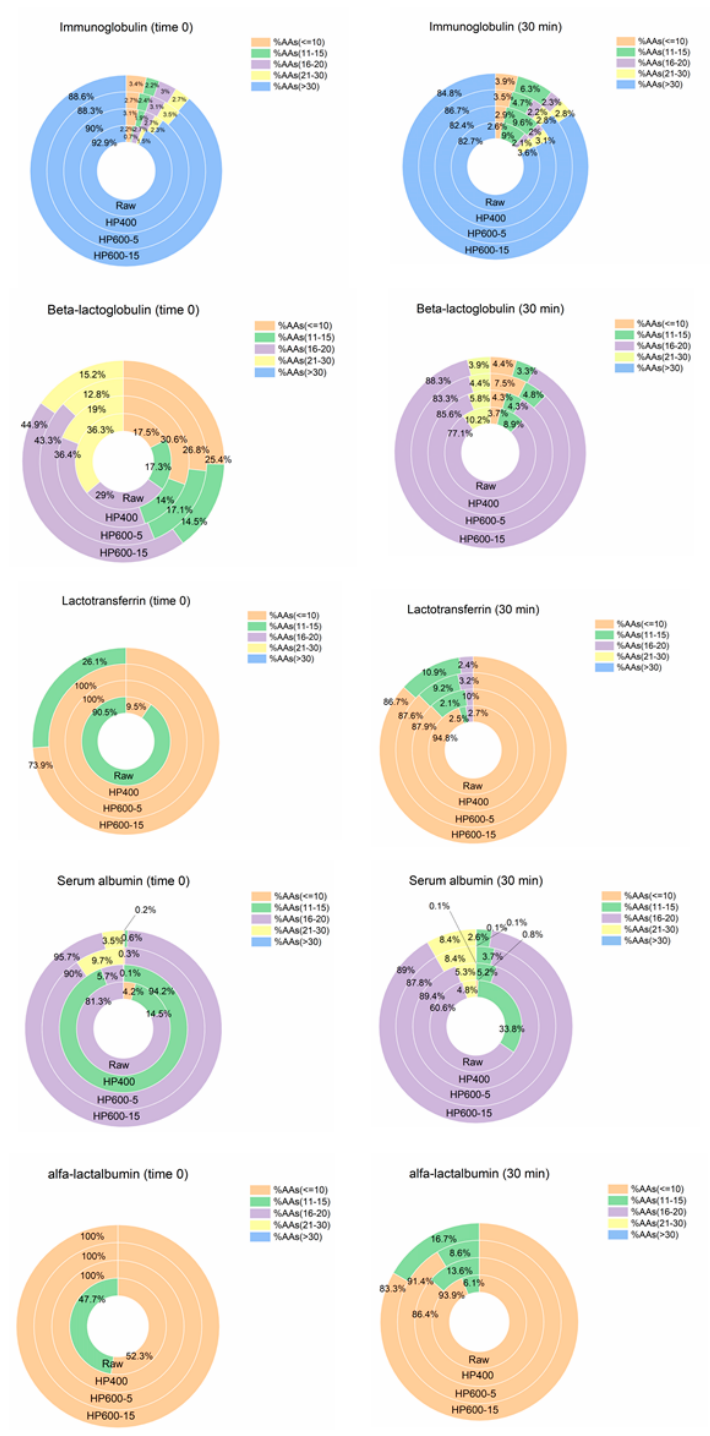
Figure 6. Peptide length distribution of major whey proteins before and after gastric in vitro digestion in raw and three HPP treated milks including both adult and elderly.